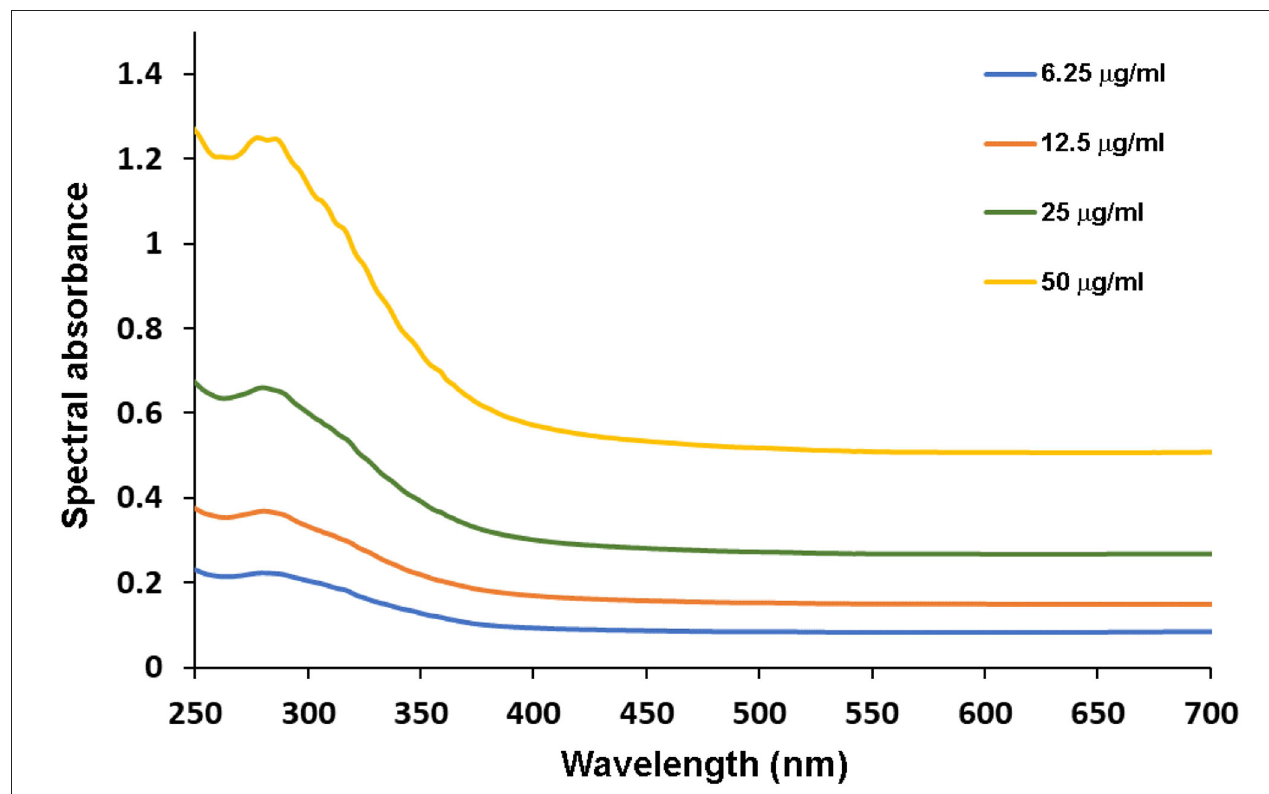
FIGURE 2 | Spectral absorbance in the UV and visible spectral regions (250–700nm) of different concentrations of the PLE extract diluted in distilled water at different concentrations (6.25, 12.5, 25, and 50 µ g/ml). Data is representative of three independent experiments made in